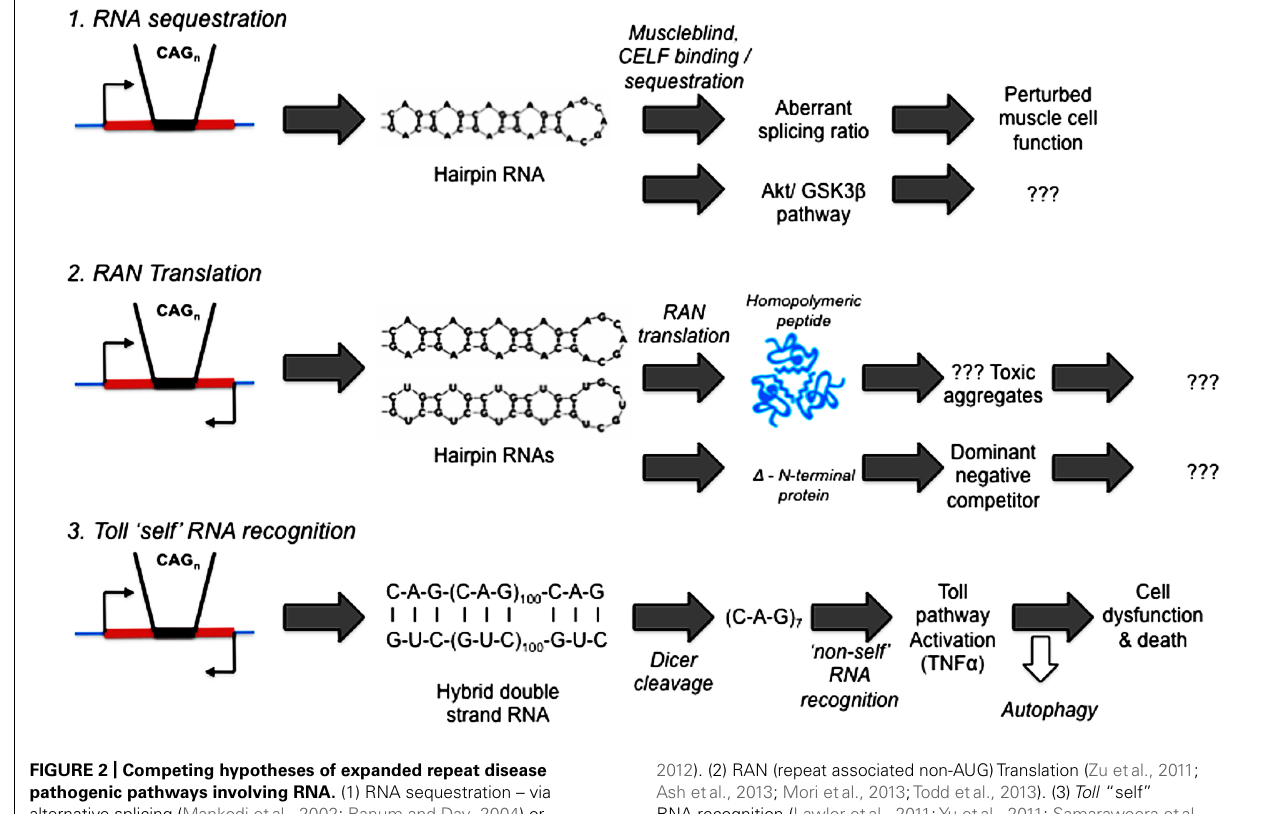
FIGURE 2 | Competing hypotheses of expanded repeat disease pathogenic pathways involving RNA. (1) RNA sequestration – via alternative splicing (Mankodi etal., 2002; Ranum and Day, 2004) or Akt/GSK3 β pathway (van Eyk etal., 2011; Jones etal., 2012; Lawlor etal.,